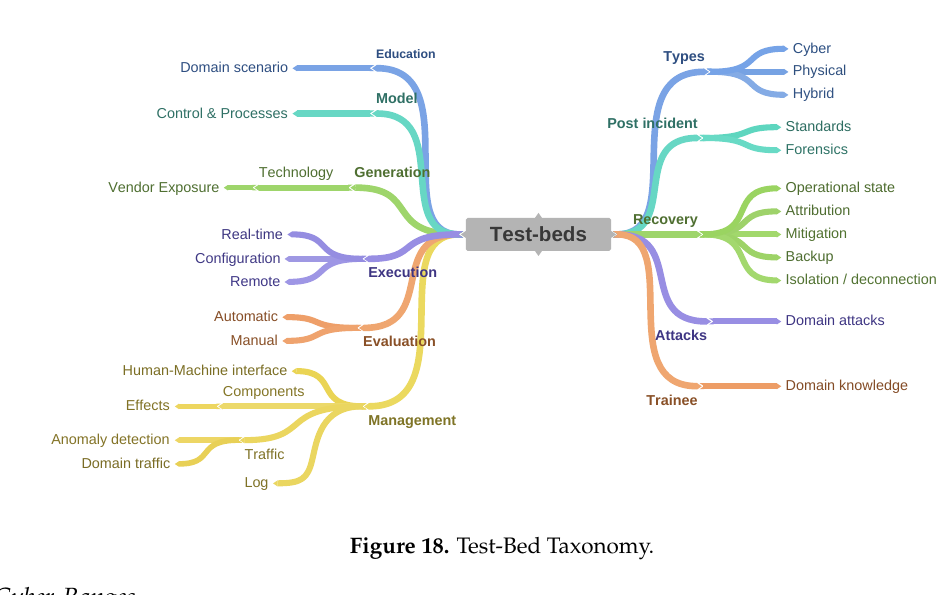
Figure 18. Test-Bed